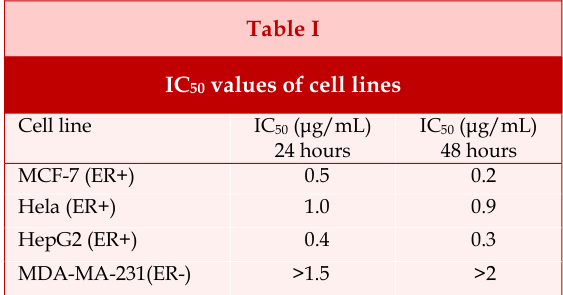
Figure 3: Effect of compound 34 on the morphological changes of two human breast cell lines MCF-7 and MDA-MB-231 cells were treated with indicated concentrations of compound 34 for 24 hours and captured by a fluores- cence microscope